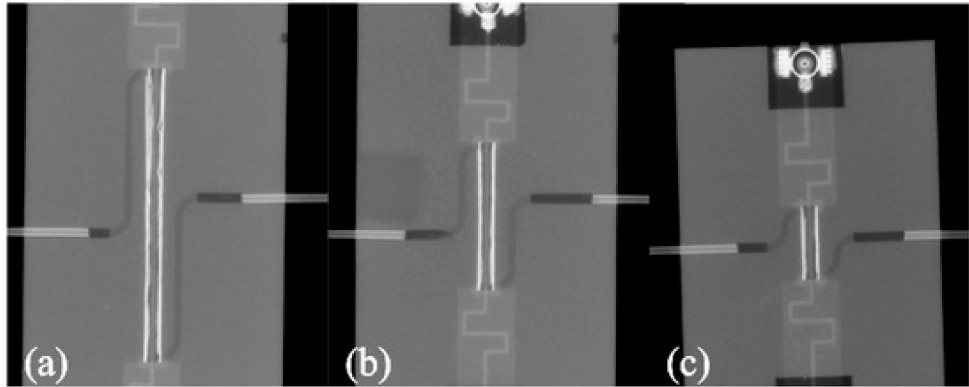
Figure 22. The X-ray images of the fabricated microreactors for the synthesis of the gold nanoparticles with the 20 mm ( a ), 10 mm ( b ) and 5 mm ( c ) long microreactor [108].